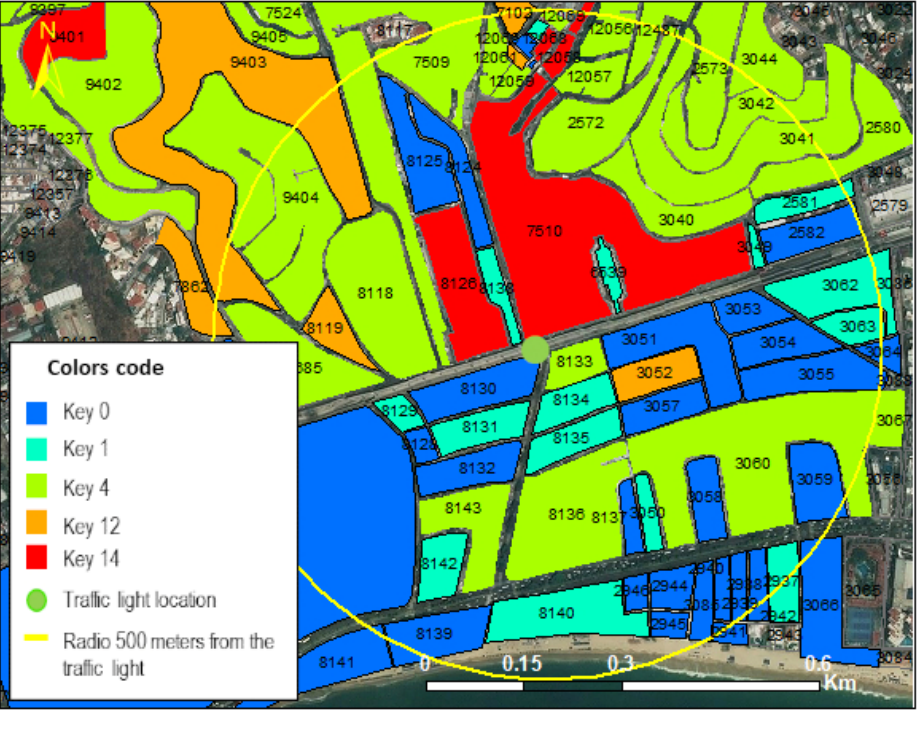
Figure 2. Traffic light “Anclas–Cuauhtémoc” with the selected blocks.